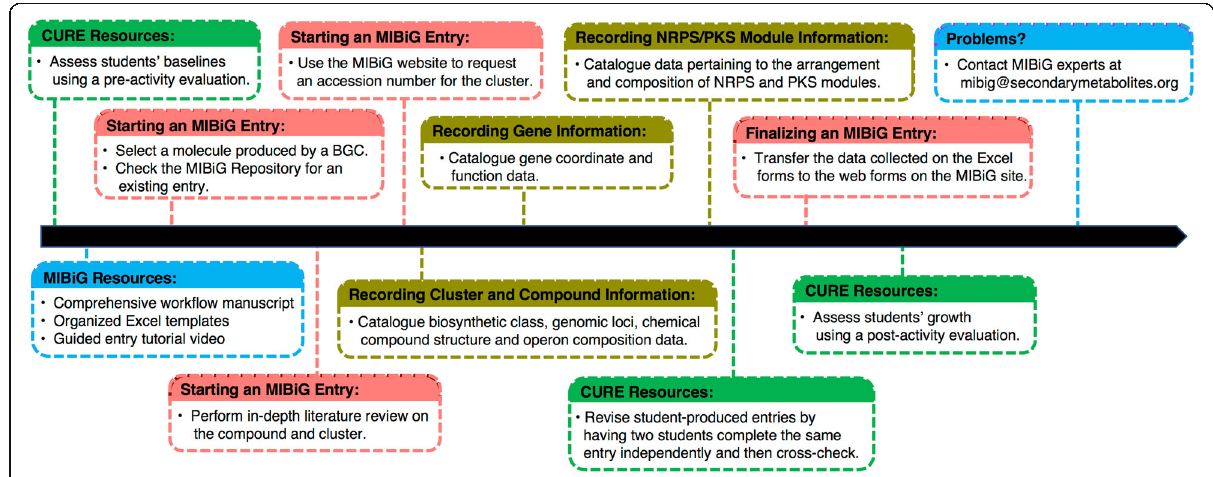
Fig. 1 Pictorial organization of the typical order of operations during completion of MIBiG submissions. This figure illustrates how all the resources we provide here can be used alongside one another most effectively. The red and yellow boxes refer to logistical and data entry steps, respectively. The resources aimed to student annotation efforts in course-based undergraduate research experiences (CUREs) are shown in green. Lastly, resources aimed at mitigating potential user complications in filling out the database are shown in